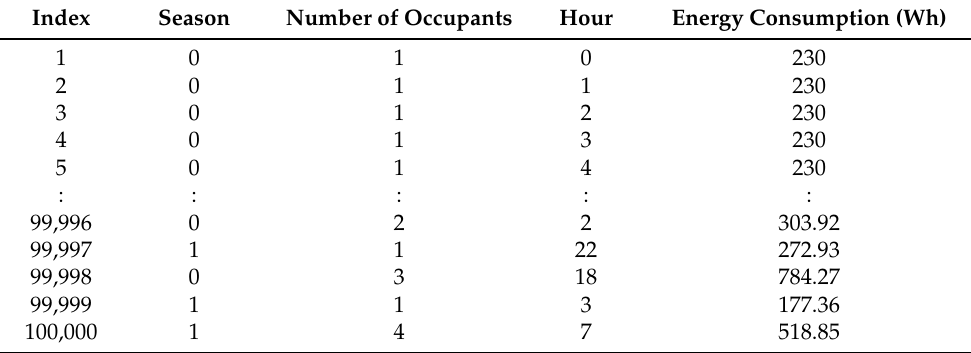
Table 10. The Final version of the load